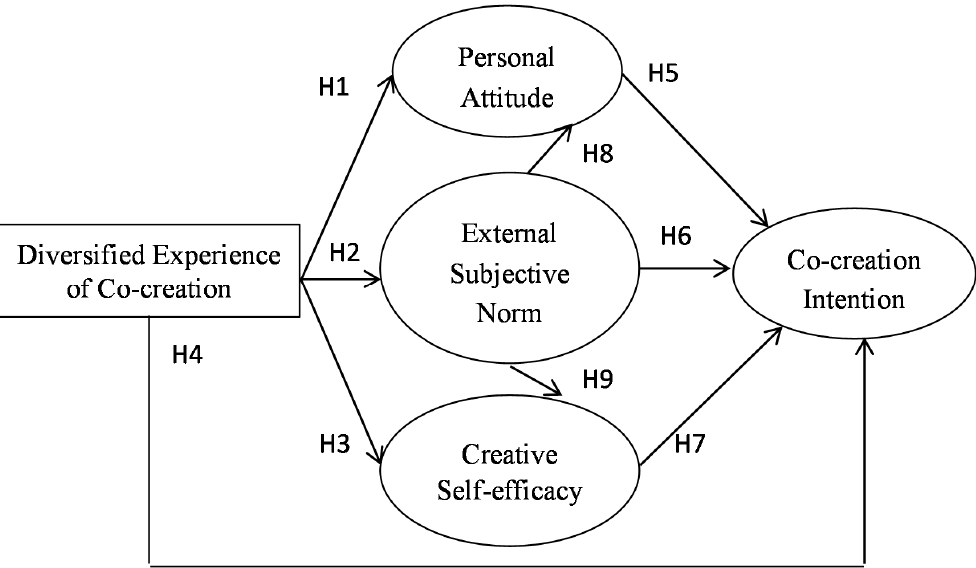
Figure 1. Research framework.